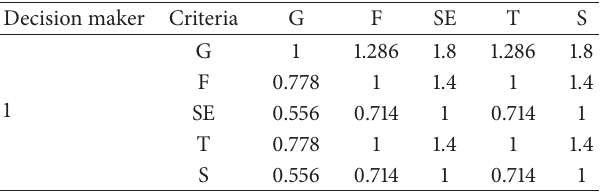
Table 6: Paired comparison matrix for main criteria level.